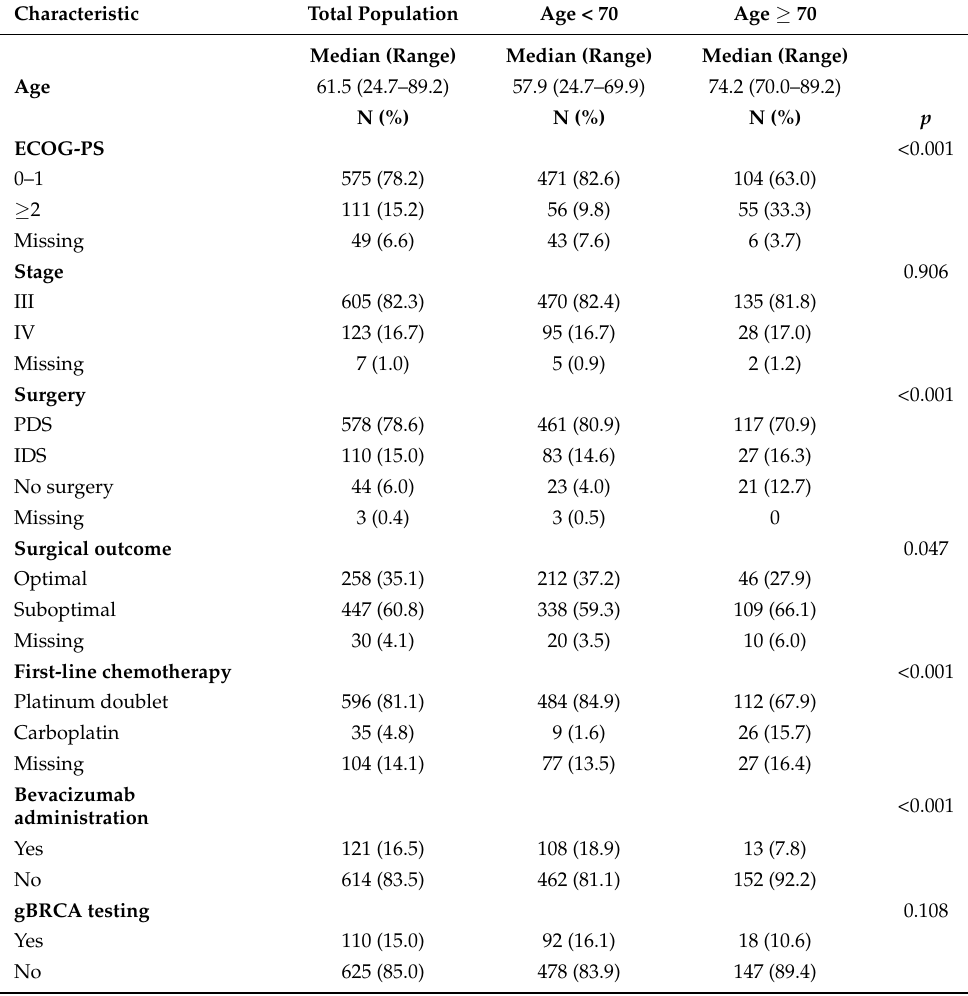
Table 1. Clinicopathological characteristics of the total population and differences in their distribution among patients older than 70 years of